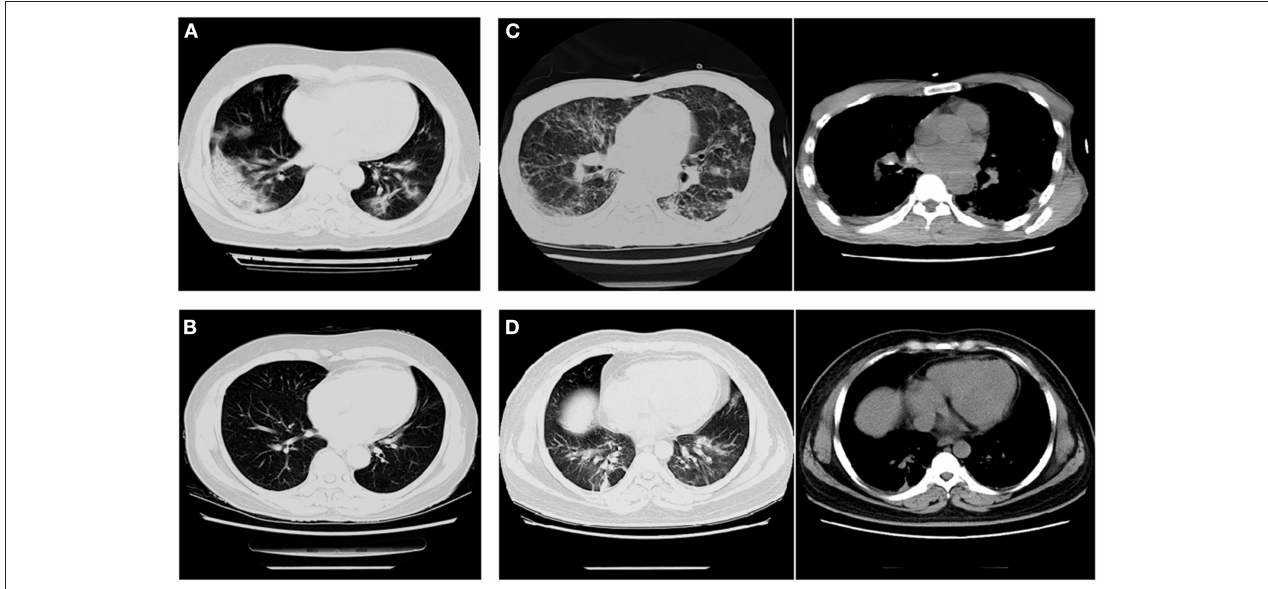
FIGURE 2 | Imaging characteristics of chest CT scans from patients with COVID-19 and influenza pneumonia. (A) A 62-year-old woman with COVID-19 (critical illness) exhibited multiple ground-glass opacities in both lungs. (B) A 63-year-old woman with influenza-B exhibited fibrous indurations in the upper left and lower right